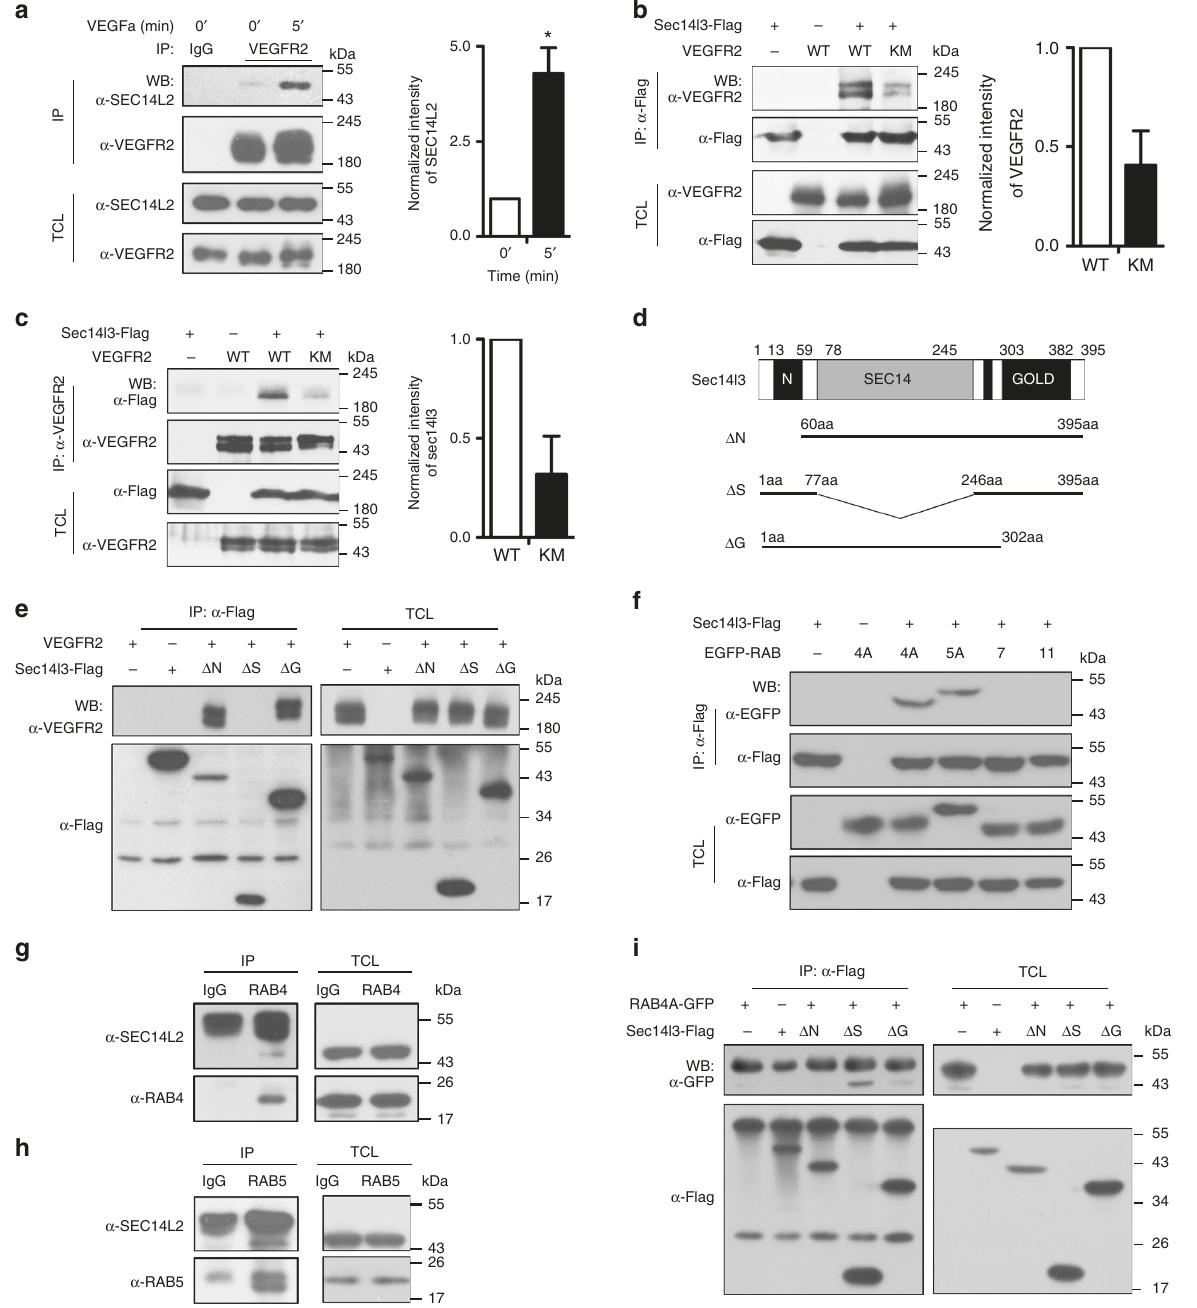
Fig. 7 Sec14l3/SEC14L2 interact with VEGFR2 and RAB4A/5A via complementary domains. a SEC14L2 interacts with VEGFR2 endogenously in HUVECs. HUVEC cells were starved and stimulated with 100 ng ml − 1 VEGFa for 5 min before harvest for IP and immunoblotting. TCL, total cell lysate. IgG serves as a negative control. Quanti fi cation of the interaction from three independent experiments is shown on the right ( n = 3). * p < 0.05. b , c Sec14l3 shows a much stronger association with WT-VEGFR2 than its kinase domain mutation form (KM-VEGFR2). Different forms of VEGFR2 were co-expressed with Flag-tagged Sec14l3 in HEK293T cells. WB, western blot. Quanti fi cation of the interaction is shown on the right ( n = 3). t -tests were used for statistical analyses in a – c . d Schematic diagrams of Sec14l3 and its truncated mutants. Numbers above the diagram indicate the corresponding amino acid positions. Δ N indicates N-terminal CARL-TRIO domain deletion; Δ S, Sec14 domain deletion; Δ G, GOLD domain deletion. e Sec14l3 interacts with VEGFR2 via its Sec14 domain. HEK293T cells were transfected with different Sec14l3 domain deletion forms with VEGFR2 plasmid respectively and harvested for IP. f Sec14l3 speci fi cally interacts with RAB4A and RAB5A. Different RAB plasmids were co-transfected with VEGFR2 into HEK293T cells respectively for co- IP assay. g , h SEC14L2 interacts with RAB4 ( g ) and RAB5 ( h ) endogenously in HUVECs. i Sec14l3 interacts with RAB4A via its CRAL-TRIO and GOLD2 domains. Source data are provided as a Source Data fi